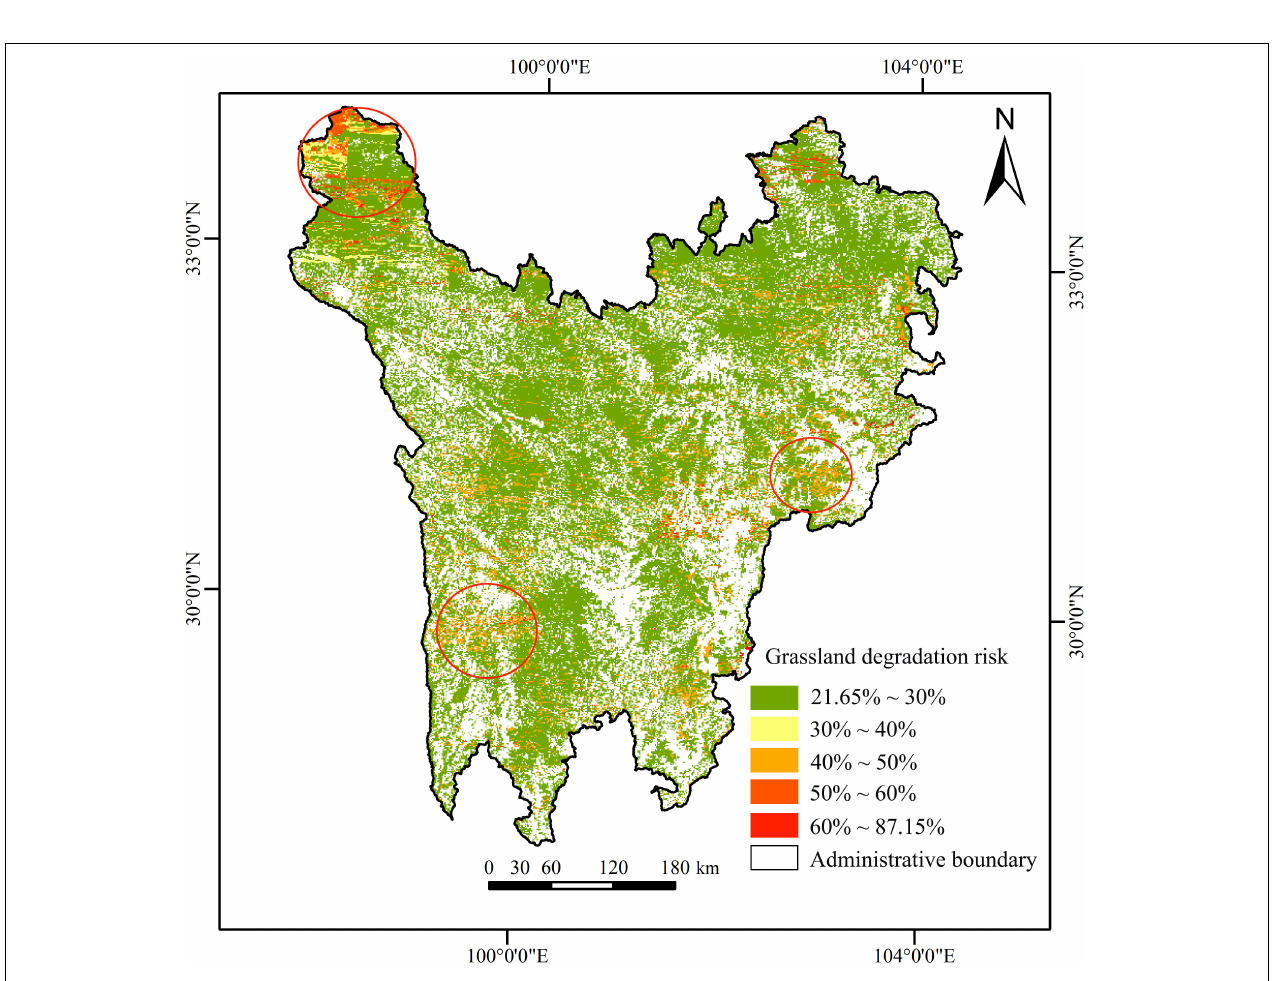
FIGURE 11 | Inference probability of grassland degradation risks based on NDVIs and SE. (A) NDVIs, slope of NDVI change. (B) SE, shrub-encroached grasslands.